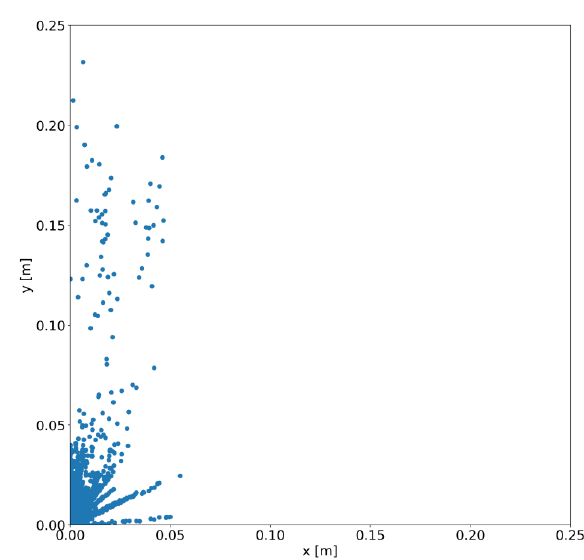
Figure 16. Distribution of the variances of the consensus sets exceeding the 80 percent threshold: The highest uncertainties appear in driving direction (along the y -axis).